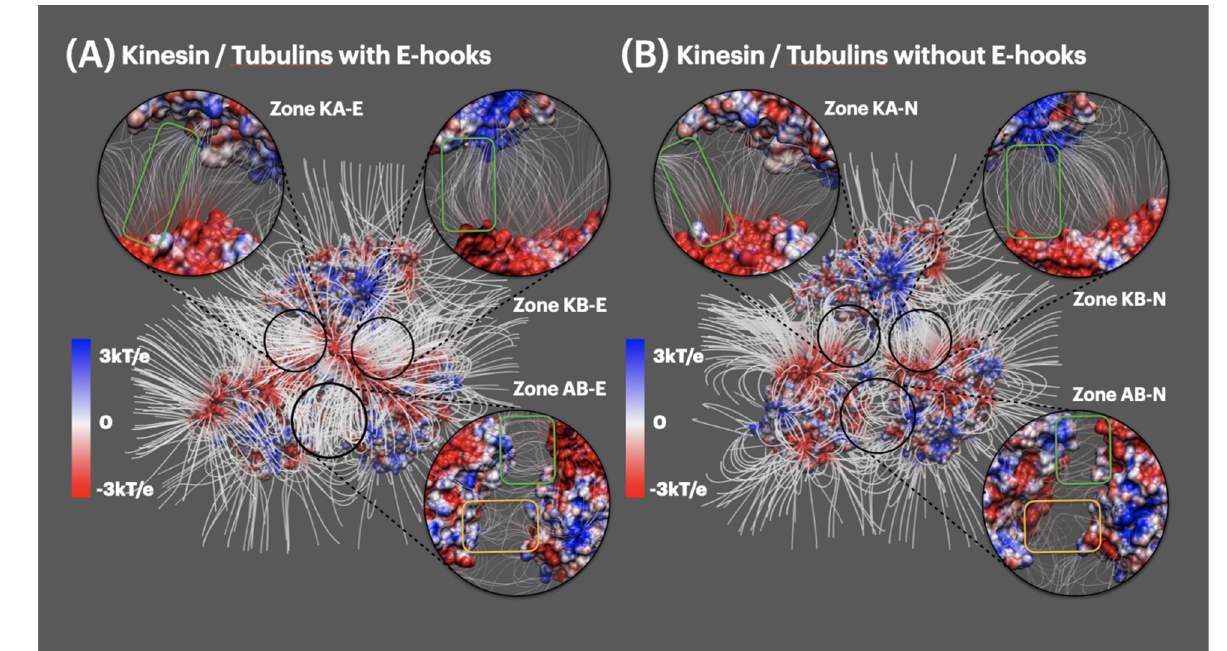
Figure 5. Electric field lines representations. ( A ) Kinesin and tubulins with E-hooks, with the closeup views of interfacial areas of kinesin and alpha tubulins (Zone KA-E), kinesin and beta tubulin (Zone KB-E), alpha and beta tubulin (Zone AB-E); ( B ) Kinesin and tubulins without E-hooks, with the closeup views of interfacial areas of kinesin and alpha tubulin (Zone KA-N), kinesin and beta tubulin (Zone KB-N), alpha and beta tubulin (Zone AB-N). Color scale: − 3.0 to 3.0 kT/e (red to blue).